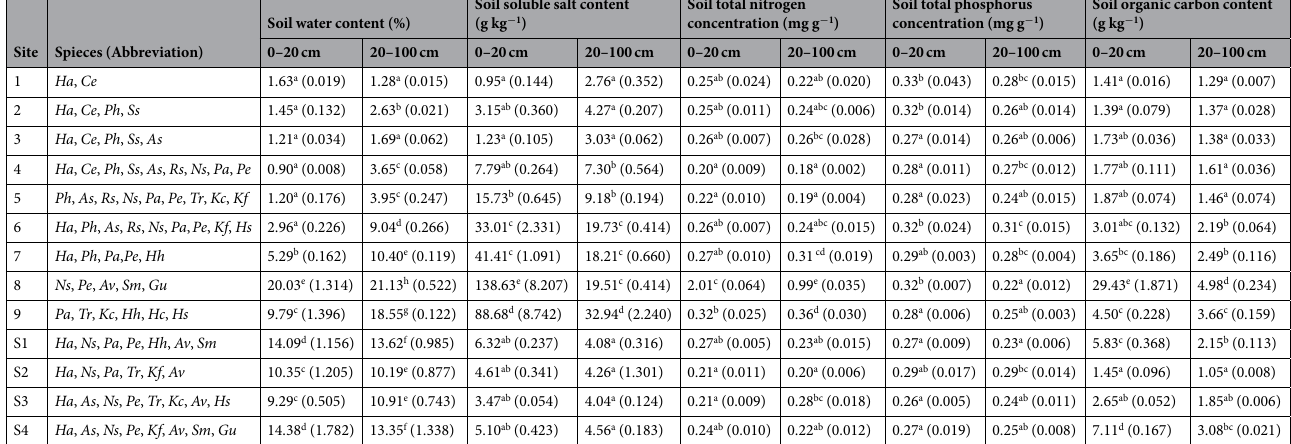
Table 1. Plant species and soil factors at thirteen sites. Values were means and error variances (in parentheses). The values for soil factors were means and standard errors at two soil depths in nine sites. Common superscript letters on the mean values within a column indicate no significant difference at P > 0.05 using LSD tests. Note: Ha * , Haloxylon ammodendron. Ce * , Calligonum ebinuricum. Ph, Poacynum hendersonii. Ss, Seriphidium santolinum. As, Alhagi sparsifolia. Rs * , Reaumuria soongorica. Ns, Nitraria sibirica. Pa, Phragmites australis. Pe, Populus euphratica. Tr * , Tamarix ramosissima. Kc, Karelinia caspica. Kf * , Kalidium foliatum. Hh, Halimodendron halodendron. Av, Apocynum venetum. Sm * , Suaeda microphylla. Gu, Glycyrrhiza uralensis. Hc * , Halostachys caspica. Hs * , Halocnemum strobilaceum. The asterisk ( * ) means that plant photosynthetic organ is assimilating shoot. Sites 1–4 are the dry s sites, sites 5–9 are the humid-saline sites, S1–S4 are the humid-non-saline sites (reference